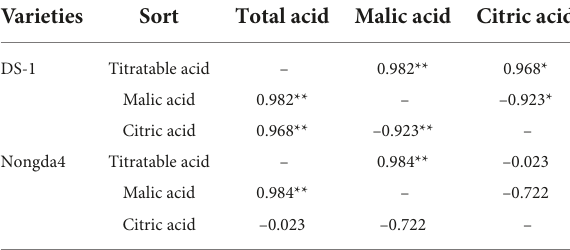
TABLE 2 Correlations of malic acid, citric acid and titratable acids.